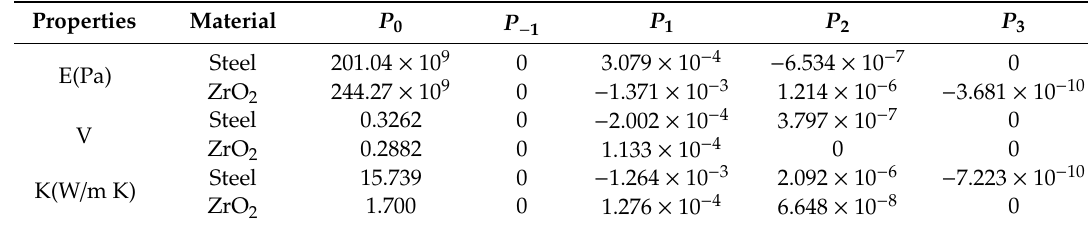
Table 1. Temperature coe ffi cients of material properties.